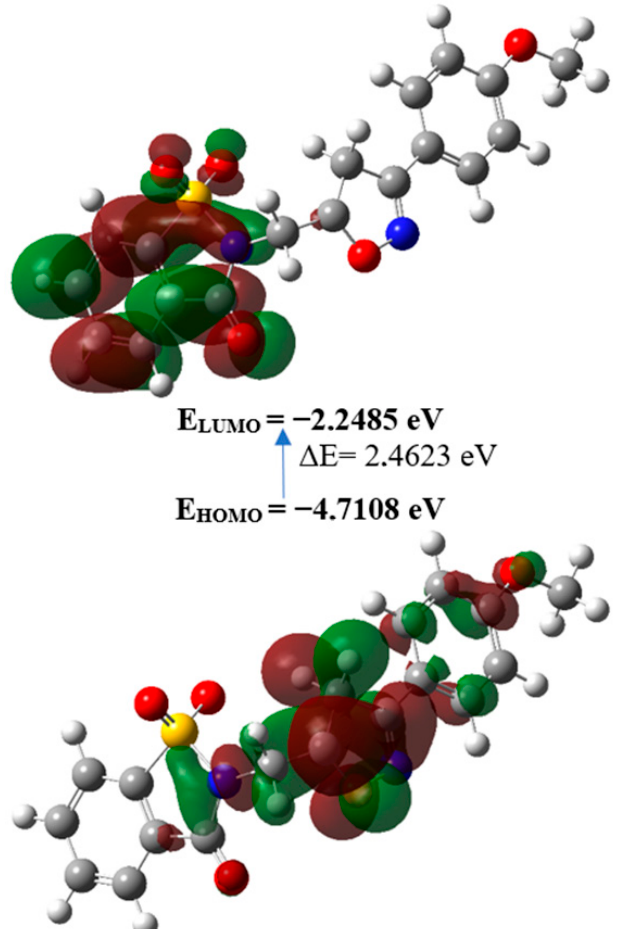
Figure 8. The energy band gap of N -(3-(4-methoxyphenyl)isoxazolin-5-yl)methylsaccharin.